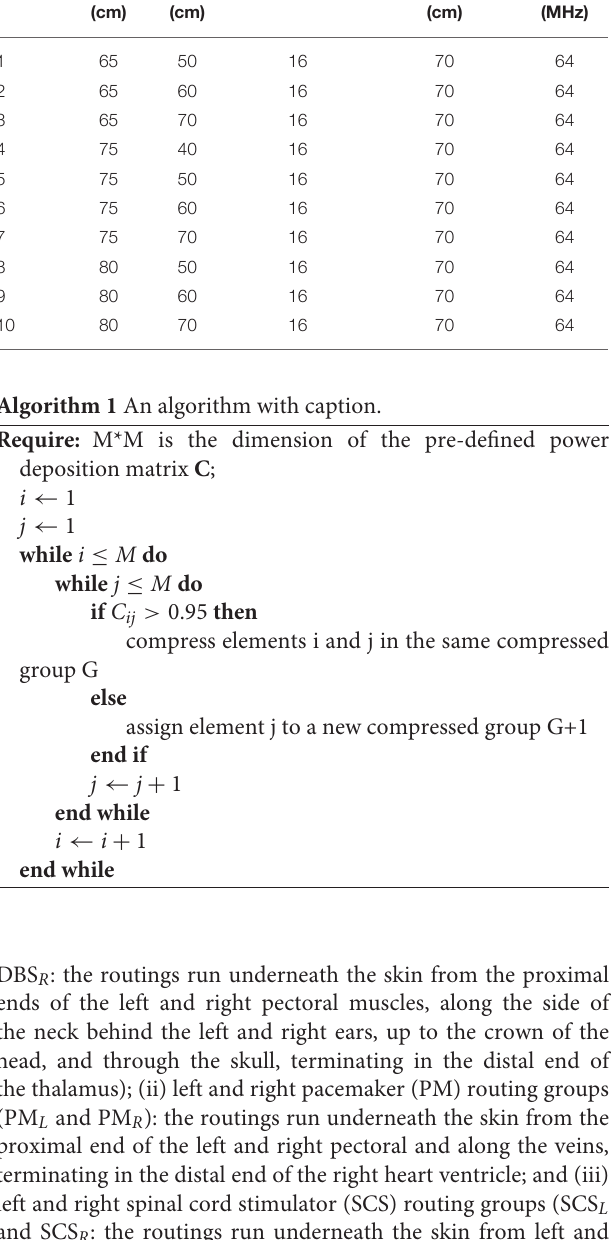
TABLE 1 | Physiological parameters of the five selected anatomical models, obtained from discretized models with a uniform grid size of 0.5 × 0.5 × 0.5 mm 3 . Anatomical model